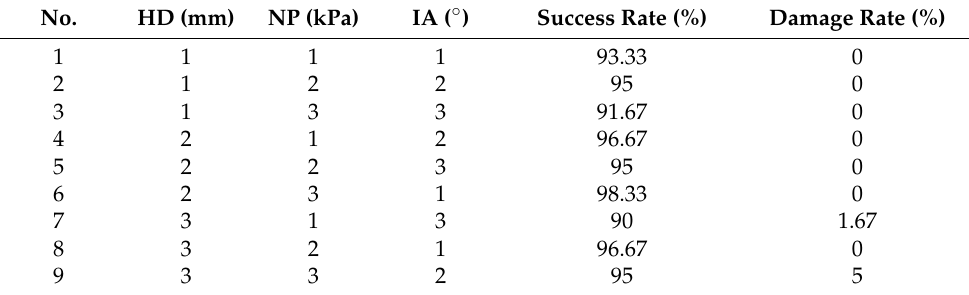
Table 3. Results of orthogonal